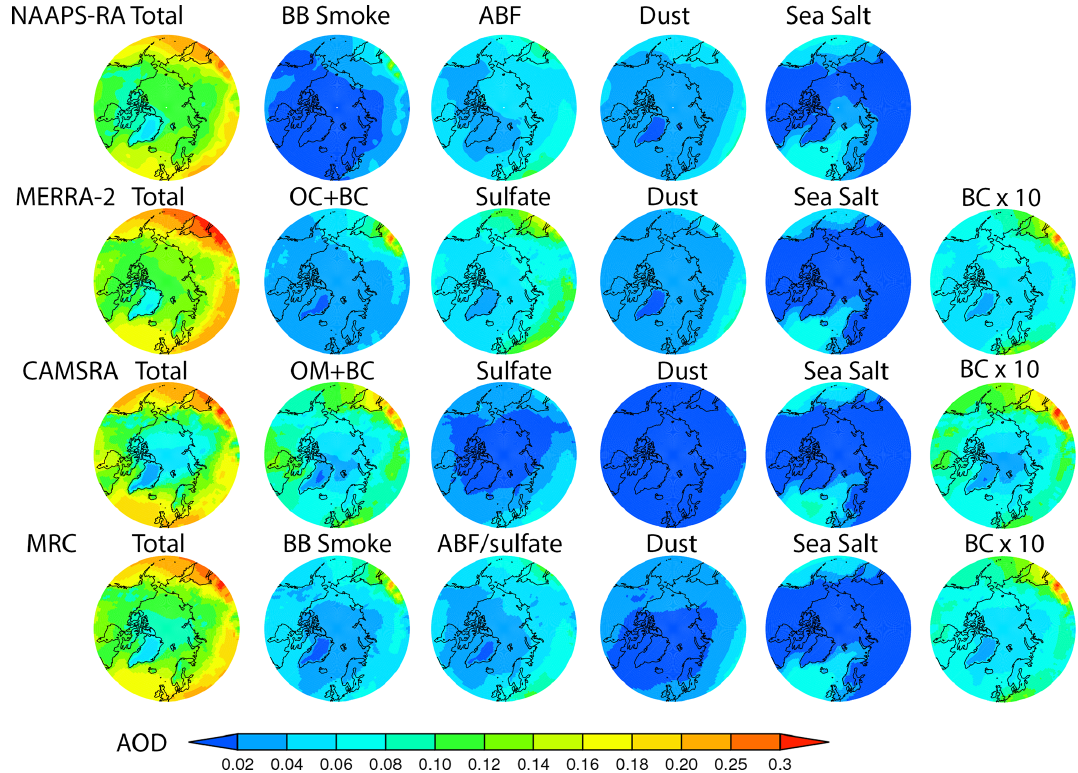
Figure 4. The 2003–2019 climatological MAM-mean total and speciated AOD at 550nm from NAAPS-RA, MERRA-2, and CAMSRA over the